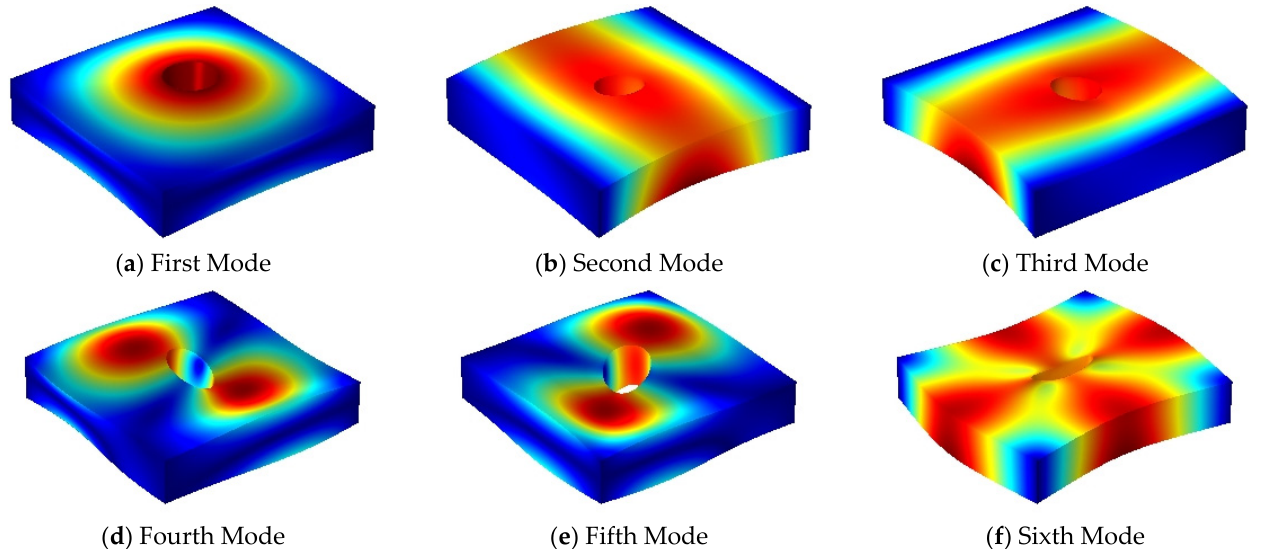
Figure 5. The first six mode shapes for SSSS-F FGMs square plate with central circular cutout ( h/a = 0.01, p = 1 ) .